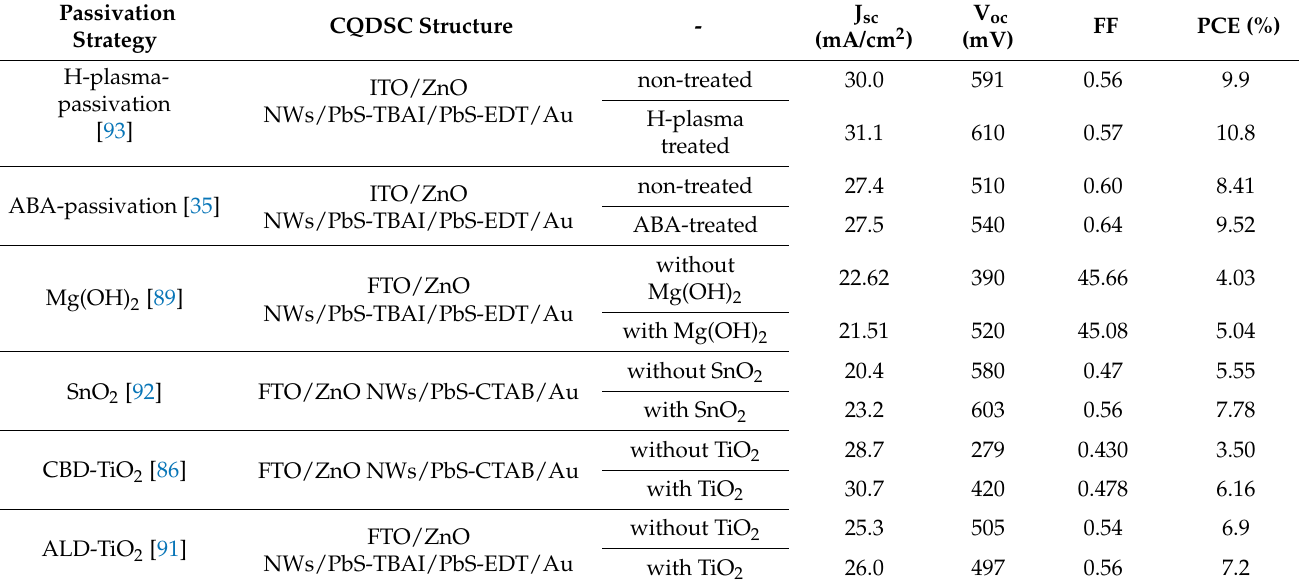
Table 4. Performance optimization of IBHJ QDSCs with passivation